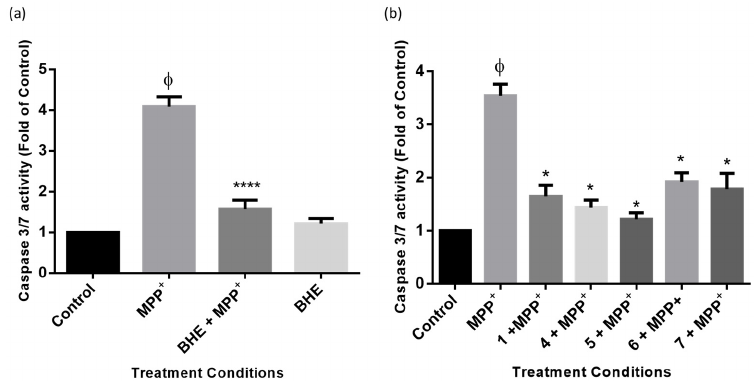
Figure 10. BHE and compounds reduce MPP + -induced caspase 3/7 activity. Cells were pre-treated with 2.5 µg/mL of extracts ( a ) and compounds ( b ) before exposure to 2000 µM of MPP + for 24 h, and activity of caspase 3/7 was determined. Each bar represents level of caspase 3/7 expressed as fold of control, and significance of difference indicated with * ( p < 0.05) and **** ( p < 0.0001) when extract/compounds are compared to MPP + and ϕ (MPP + vs. control) .